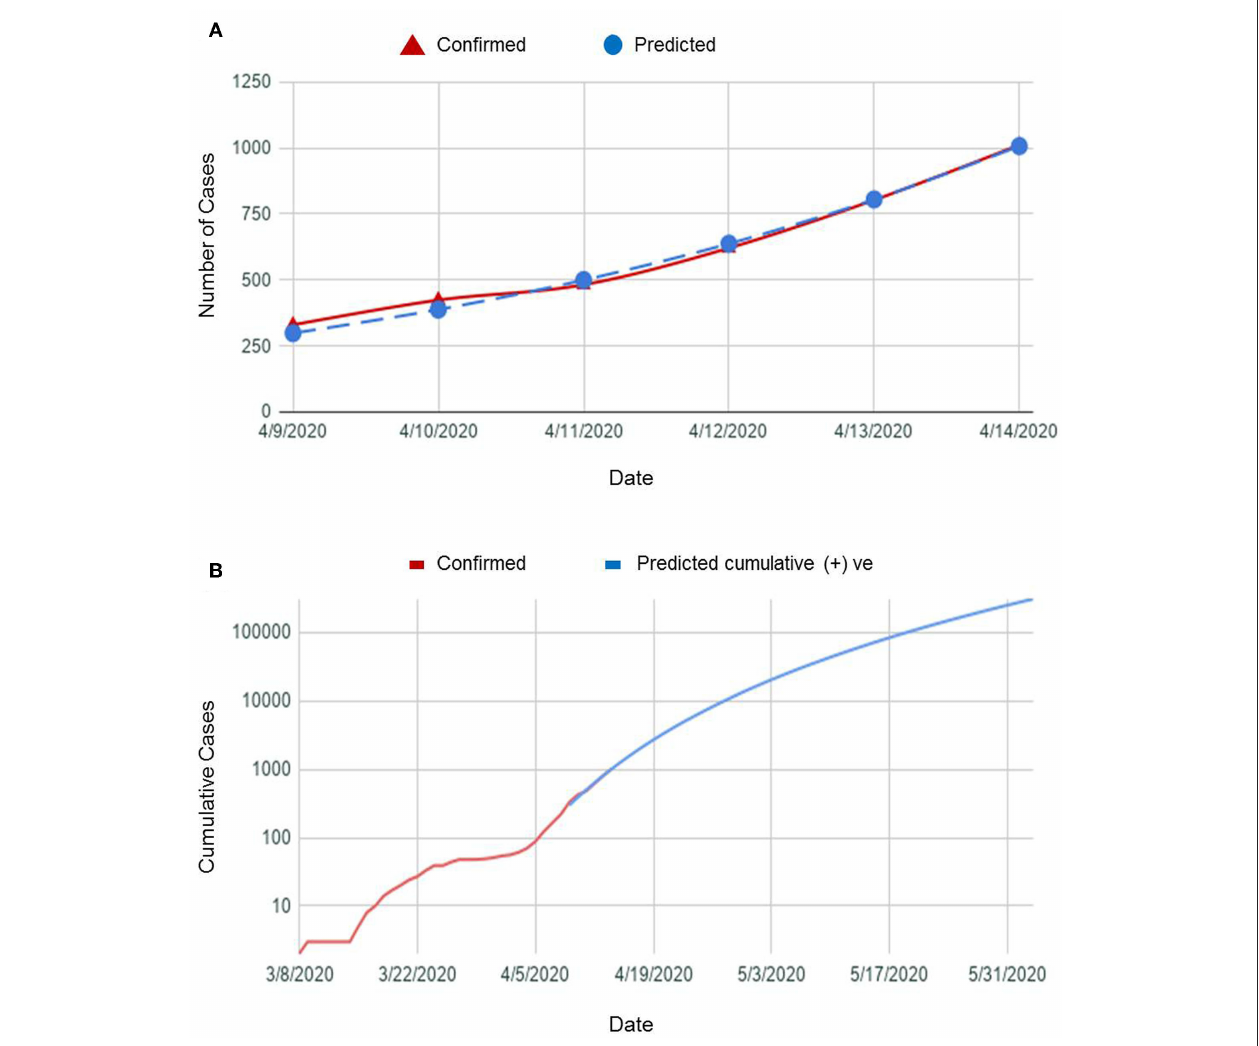
FIGURE 8 | (A) A plot of COVID-19 confirmed cases vs. predicted cases in a week and (B) a graph showing predicted cumulative COVID-19-positive cases in near future.